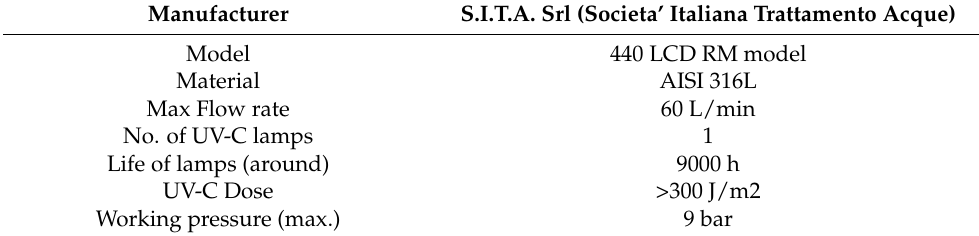
Table 2. UV unit